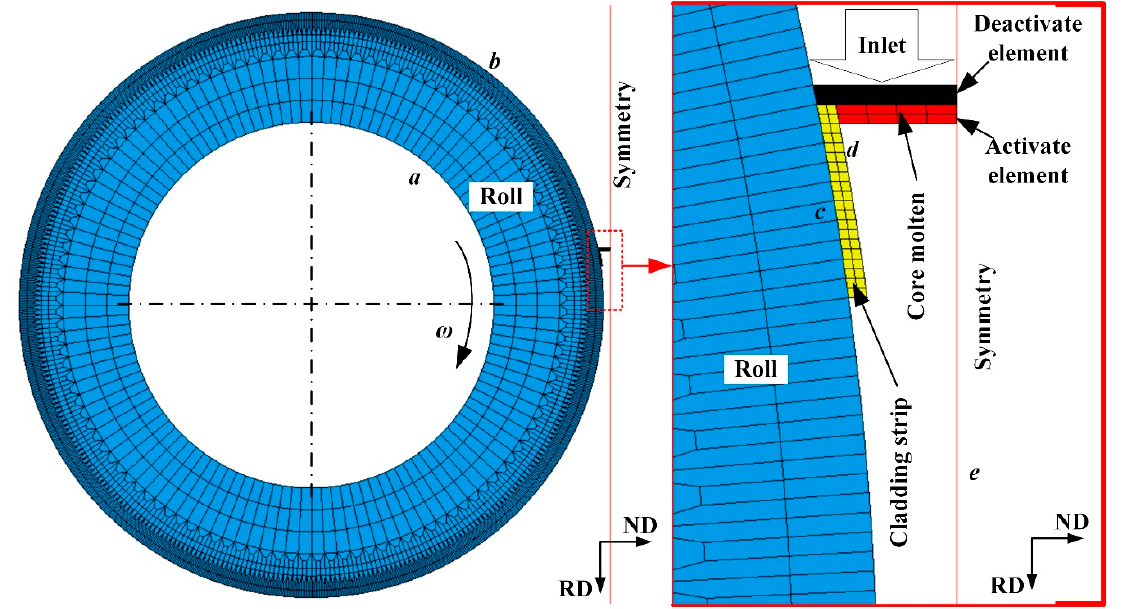
Figure 3. Mesh model of SLS-TRC for three-laminated aluminum composite plate.